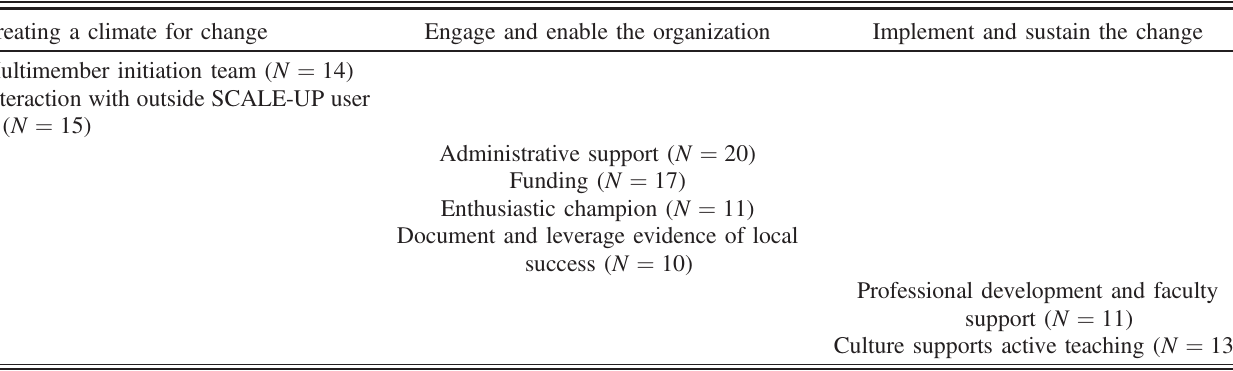
TABLE II. Common enablers organized by three main steps in Kotter ’ s Change Model. N indicates the number of interviewees who explicitly indicated the importance of the relevant factor, out of a total of 21 implementation efforts. Creating a climate for change Engage and enable the organization Implement and sustain the change Multimember initiation team ( N ¼ 14